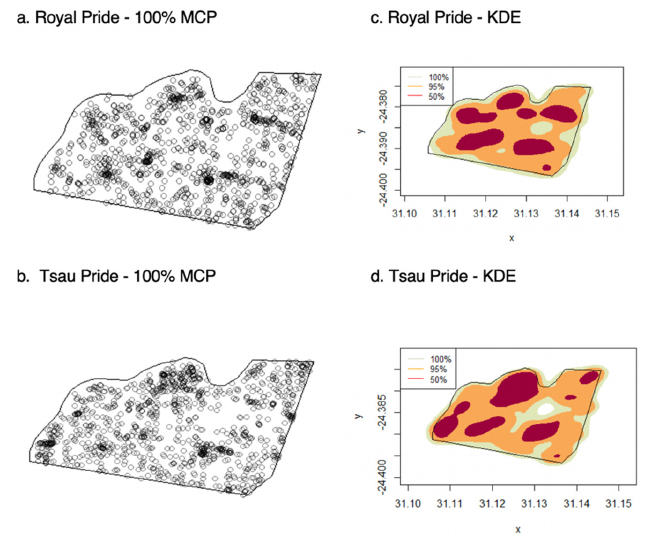
Figure 3. Recorded locations and home range distribution for the Royal and Tsau prides, using 100% MCP( a , b ), and KDE(100%, 95% and 50%) ( c , d ).